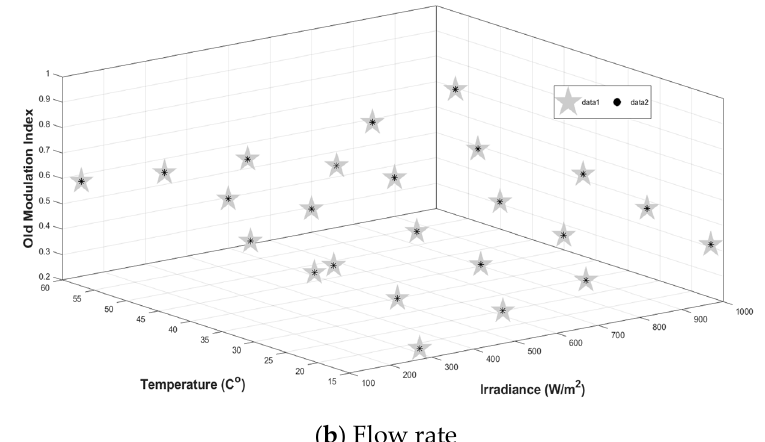
Figure 12. Trained input/output data.